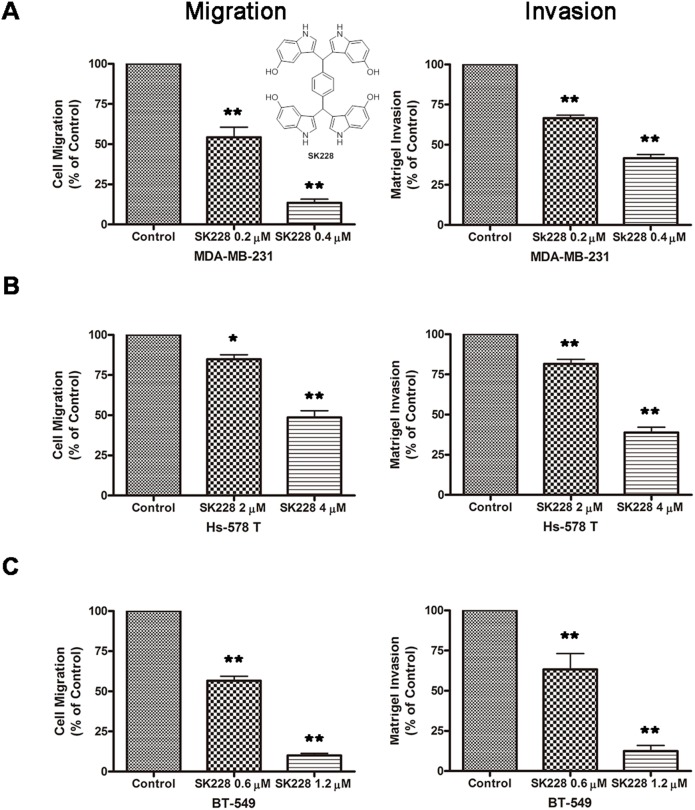
SK228 treatment results in the reduced in
vitro migratory and invasive potential of breast cancer cells.Chemical structure of SK228 is shown. Cells were treated with different concentrations of SK228 or DMSO for 24 h. After incubation, cells were transferred to transwells and given 24 h to migrate or invade. (A) Quantitation of the migratory and invasive abilities of MDA-MB-231 cells (**P<0.01). (B) Quantitation of the migratory and invasive abilities of Hs-578 T cells (*P<0.05, **P<0.01). (C) Quantitation of the migratory and invasive abilities of BT-549 cells (**P<0.01).